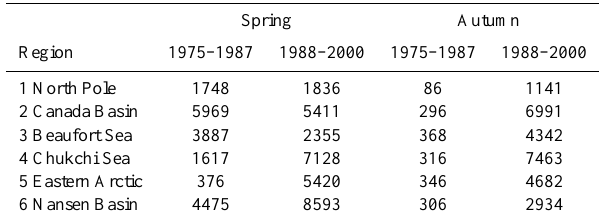
Fig. 1. Annual Arctic Oscillation index (AO) and Dipole Anomaly index (DA). Years 1975–1987 are marked with blue and years 1988–2000 with red color. Circles denote the mean values of these 13-year periods.